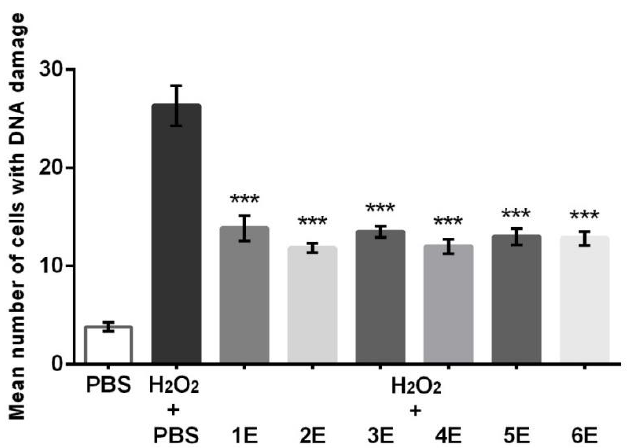
Figure 3. Antigenotoxic properties of methanol extracts of H. officinalis subsp. aristatus (1E–6E) against DNA damage in human peripheral blood leukocytes, induced by hydrogen peroxide (H 2 O 2 ) in post-treatment protocol. Bars represent the mean value of cells with DNA damage ± standard error of the mean (SEM) versus the control treated with H 2 O 2 ( n = 3). PBS: phosphate-buffered saline solution. *** p < 0.0001.